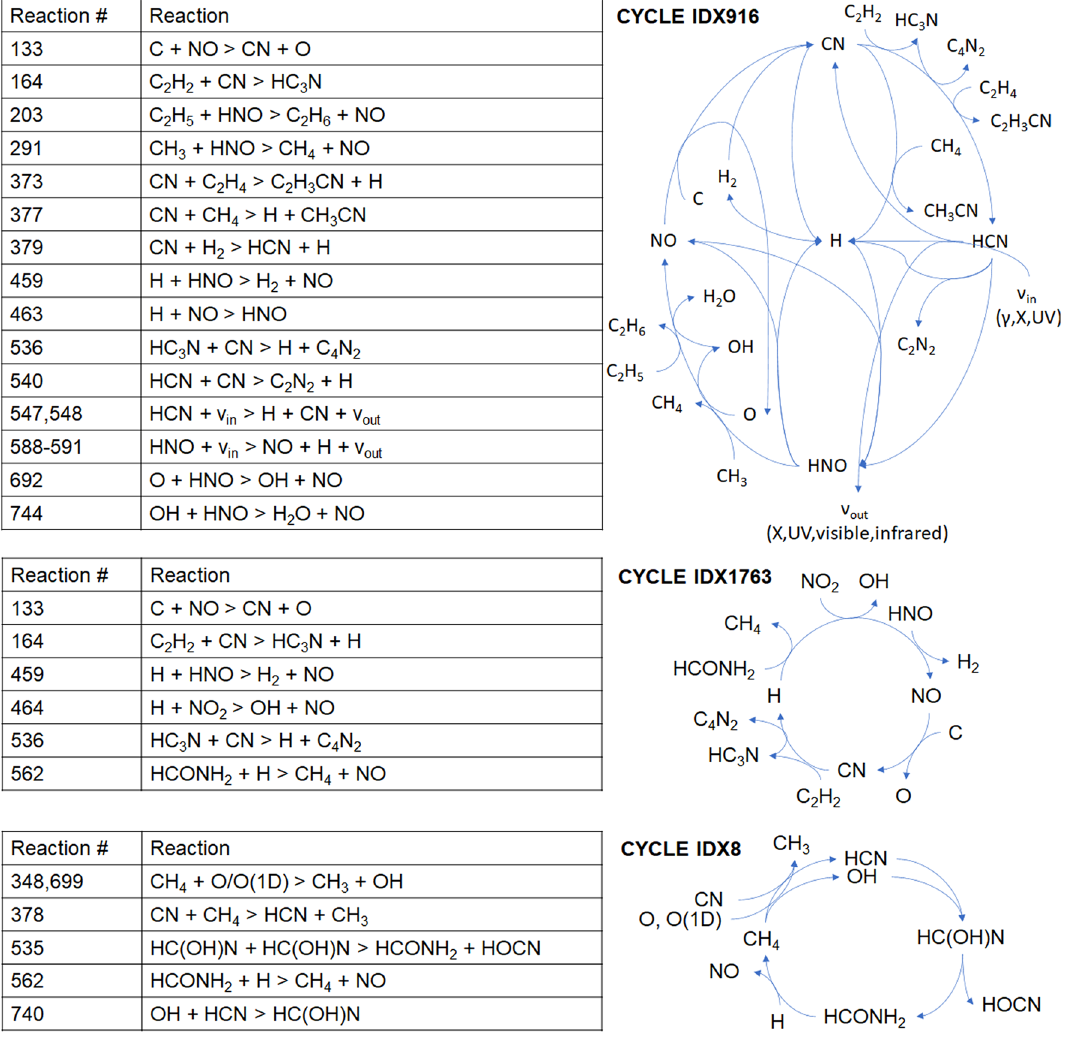
Figure 2. Three examples of simple cycles (IDX8, IDX1763 and IDX916) with net reactions that do not reduce to reactions present elsewhere within the radiolytic network. For simplicity, cycle depictions do not include